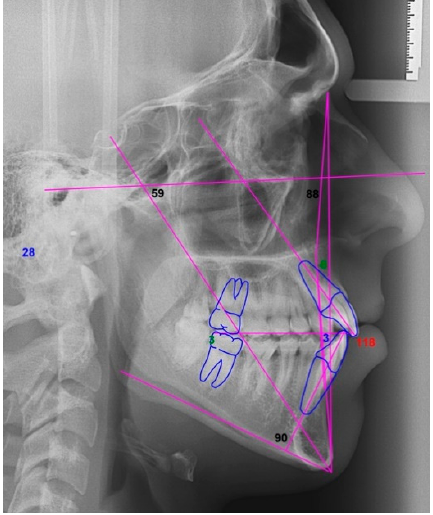
Figure 6. Case 1: cephalometric image.